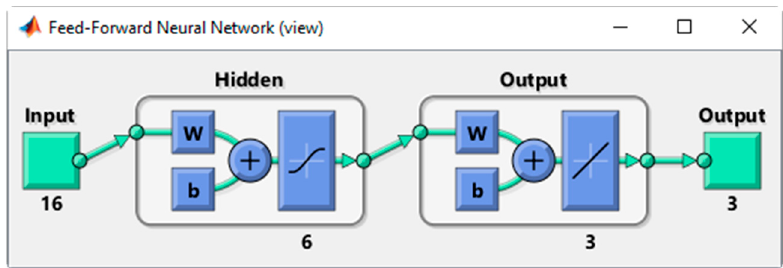
Figure 2. Artificial neural network architecture. The 16 inputs correspond to the features based on raw inertial signals defined in Table 1. Features are then processed at the hidden layer level composed of six neurons. Weights and bias are attributed for all inputs during the training process and neuron are activated following a symmetric sigmoid function. The resulting activation patterns are then again adjusted (output layer’s weights and bias) and summed up to determine the final classification.